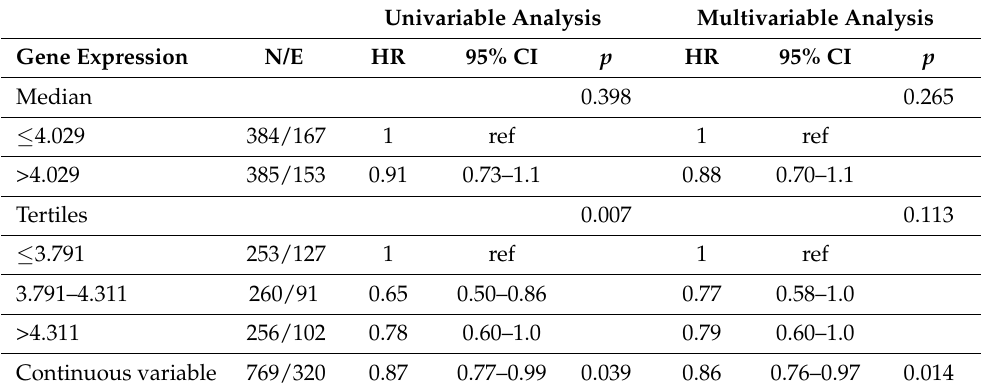
Table 18. Event Free Survival of 769 NB patients in relation to GREB1 expression levels evaluated by the Cox regression